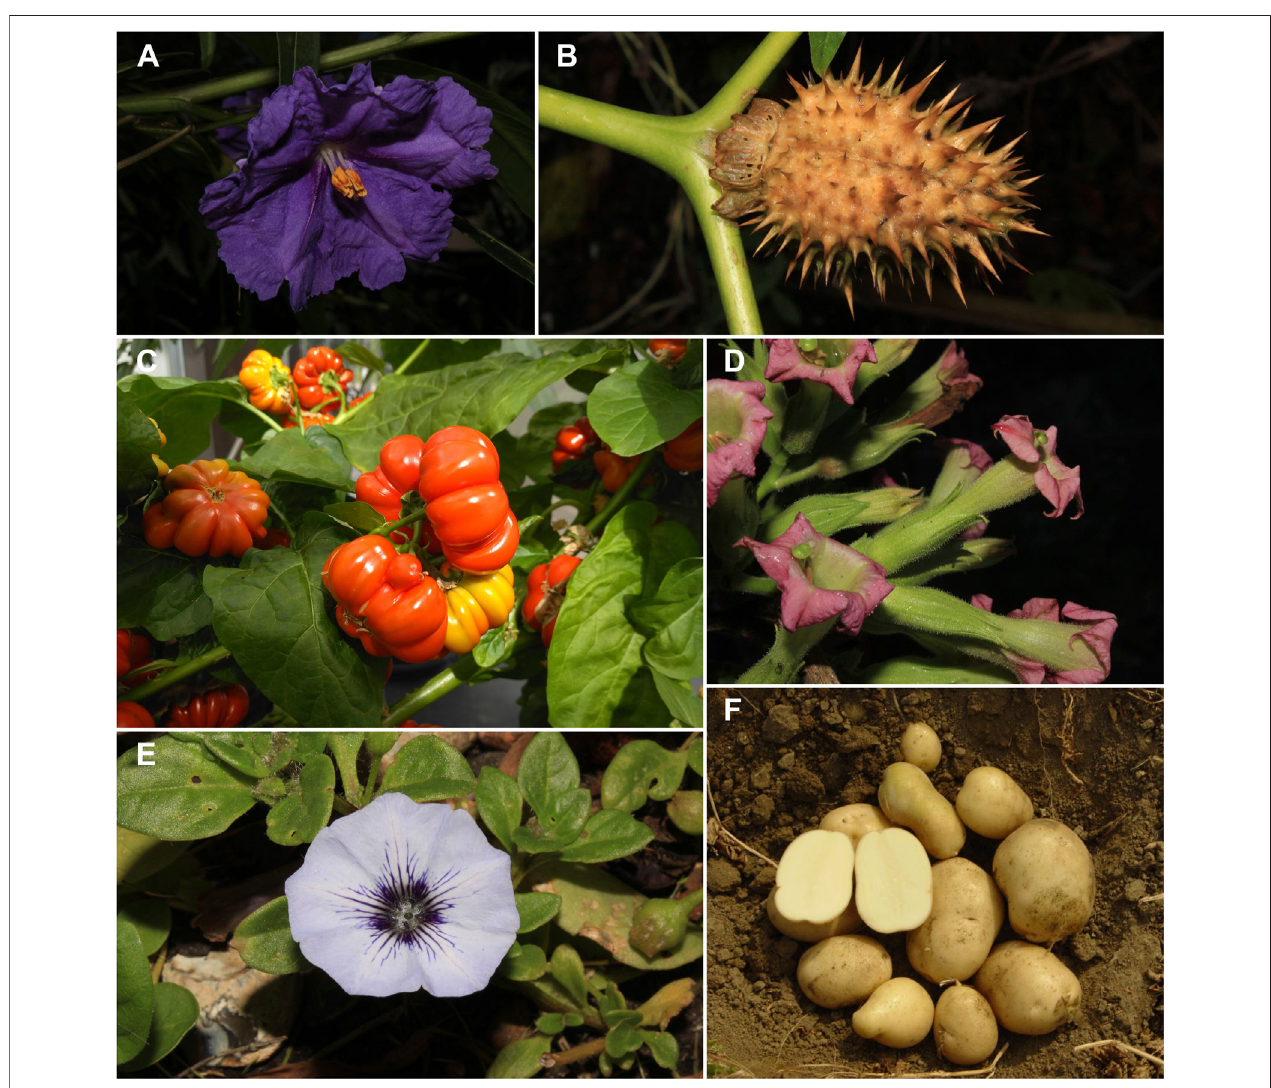
FIGURE1| DiversityofSolanaceaecrops,poisonousweeds,andrelatives. (A) Solanumlaciniatum Aiton, (B) Daturastramonium L., (C) Solanumlycopersicum L., (D) Nicotianatabacum L., (E) Nolanahumifusa (Gouan)I.M.Johnst., (F) Solanumtuberosum L.A-B,D-EphotographsbyR.DeannaatChelseaPhysicsGarden;CbyP. Poczai; F by D.